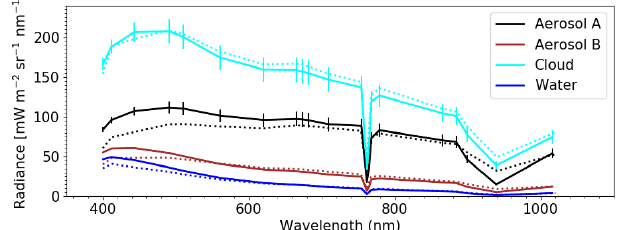
Figure 3. The OLCI radiances (solid lines) at the four locations marked in Fig. 2. The error bars are standard deviation of the OLCI radiances within the square markers in Fig. 2. Note that for Aerosol B and Water the error bars are small and thus not shown. The dotted lines are radiative transfer model simulations of the OLCI measurements. See Sect. 2.3 for further